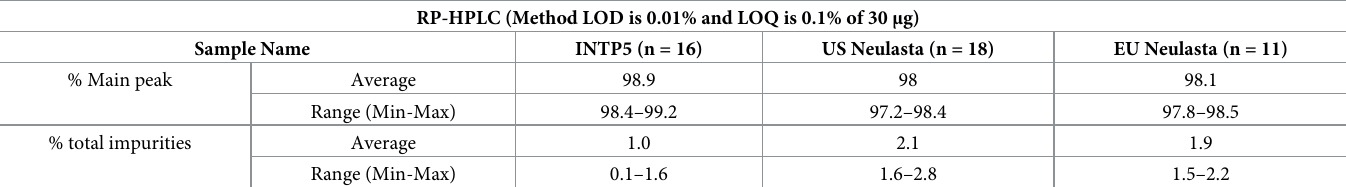
Table 4. Quantitative purity analysis of INTP5, US Neulasta and EU Neulasta by